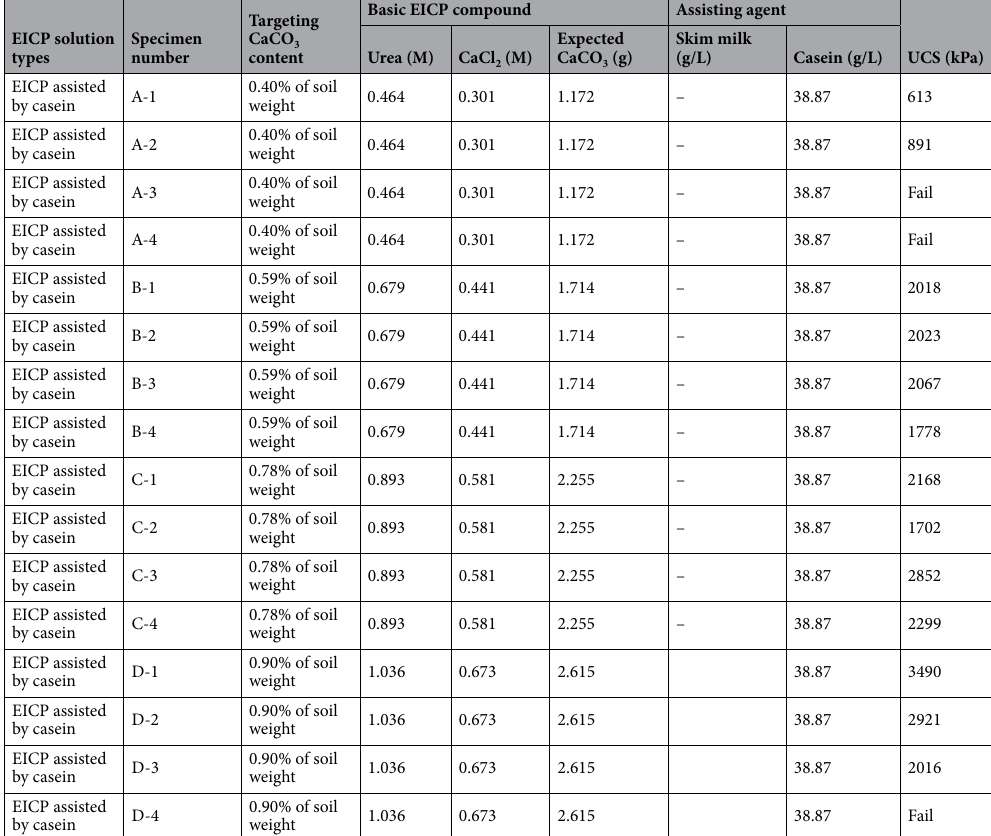
Table 2. Specimen information and corresponding UCS results of the EICP-compound optimization study with fixed casein content. All specimens involved 2.6 g/L of urease enzyme. The urea/calcium chloride concentrations were determined to meet the theoretically targeted calcium carbonate precipitation (0.4, 0.6, 0.8, and 0.9 wt% of soil). All specimens were cured at 25 °C for 72 h and then dried at 40 °C.